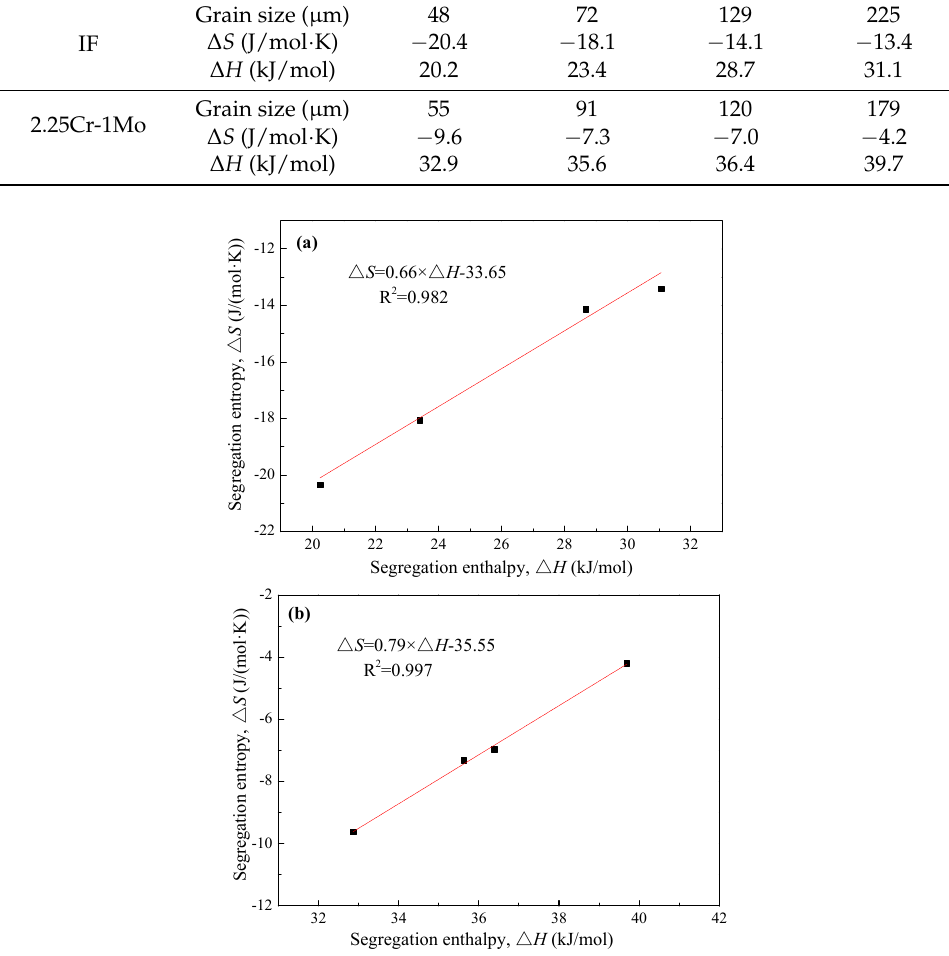
Figure 6. Relationship between phosphorus segregation entropy and enthalpy for: ( a ) IF steel; and ( b ) 2.25Cr-1Mo steel.